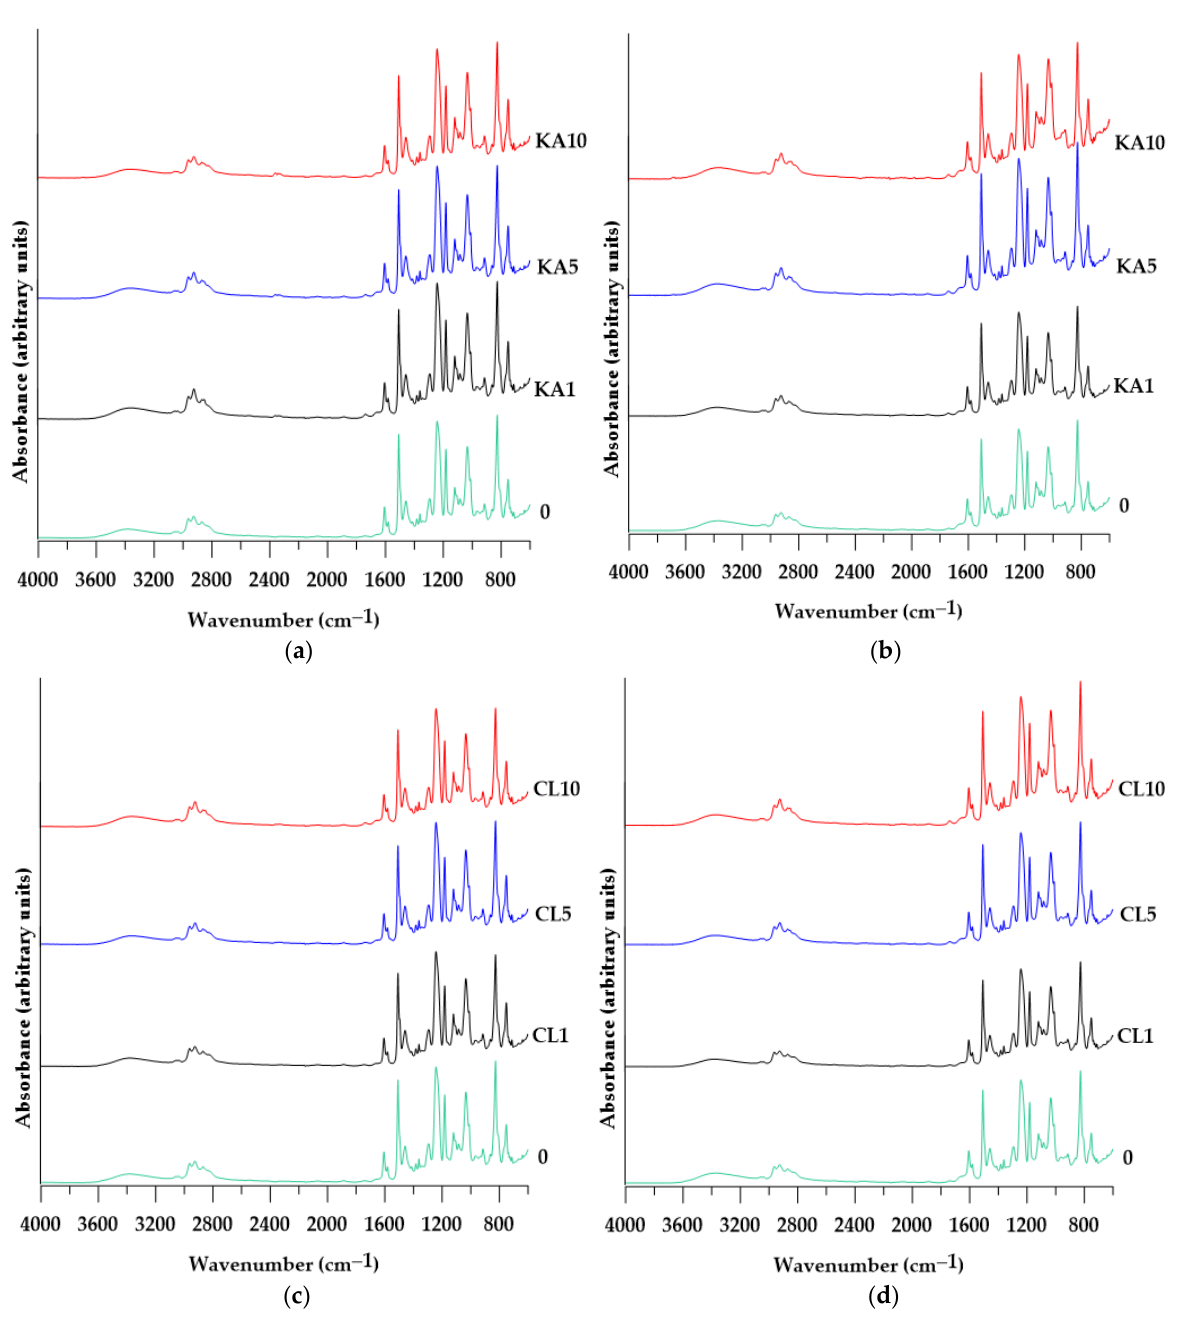
Figure 6. ATR/FTIR spectra of the materials obtained ( a ) KA before DMA analysis; ( b ) KA after DMA analysis; ( c ) CL before DMA analysis; ( d ) CL after DMA analysis.